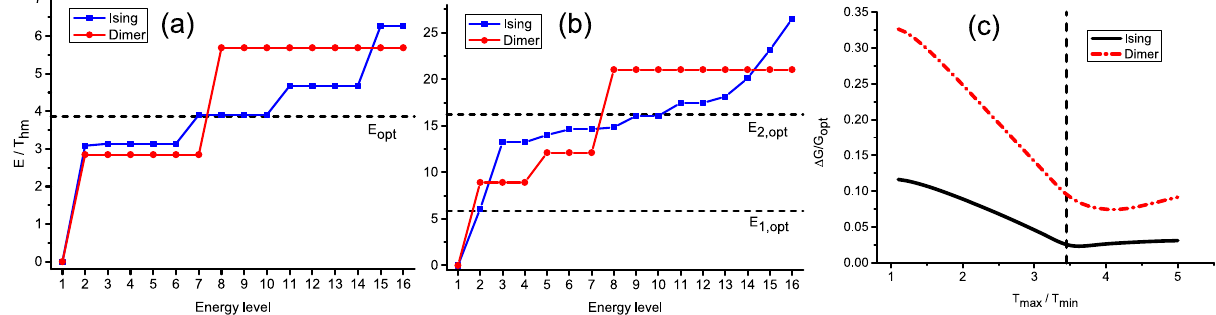
Fig. 4 Comparison of global thermometers. Comparison of energy levels between the Ising model (blue squares, obtained from optimizing the XYZ Hamiltonian H XYZ ) and the dimerized chain (in red circles, obtained from optimizing the XYZ Hamiltonian H XXX ). The energy levels are normalized against T T and T (the lower and upper bounds of the temperature range respectively). The number of spins is n = 4 hm , the harmonic mean of min max (corresponding to N = 2 n = 16 energy levels), and the optimal energies (dashed lines) are calculated for two different temperature ratios: a T max = T min ¼ 1 = T ¼ 5 (corresponding to Phase 2 in Fig. 1b). E (corresponding to Phase 1 in Fig. 1b). E opt indicates the optimal energy level for the excited state. b T 1, max max E fi rst and second excited states, respectively. The Ising energy levels are on average of closer proximity 2,opt indicate the optimal energy level for the opt and = T for the Ising model (black solid line, to the optimal energies. c Relative difference in the global thermometry measure G against temperature ratio T max min obtained from optimizing H XYZ ) and the dimerized chain (red dash-dotted line, obtained from optimizing H XXX ). G opt is the theoretical lower bound for the G value. The number of spins is n = 4, compared to the ideal case with N = 16 energy levels. The dashed line indicate the critical ratio for the ideal